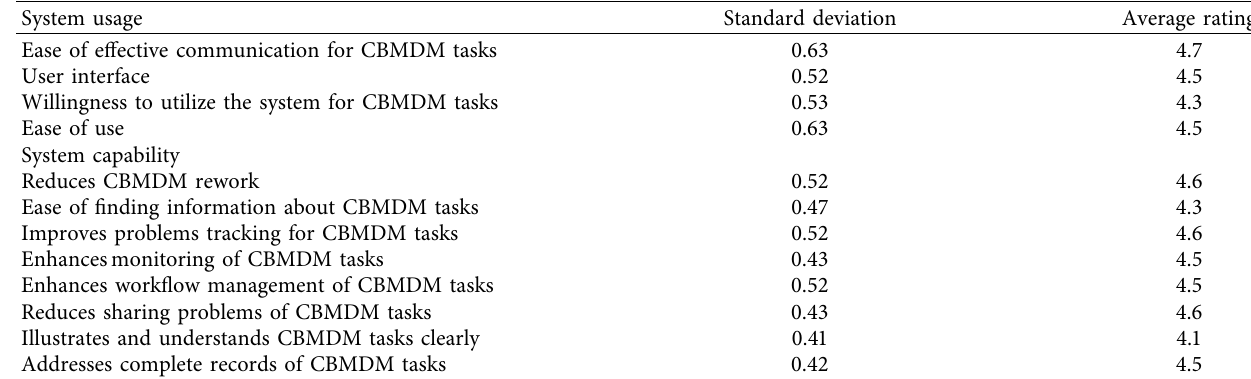
Table 2: System evaluation result.